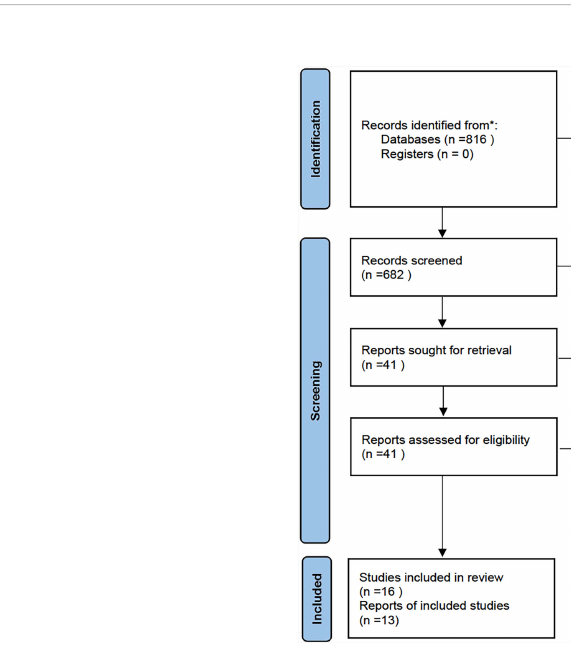
FIGURE 1 Flowchart diagram for the literature